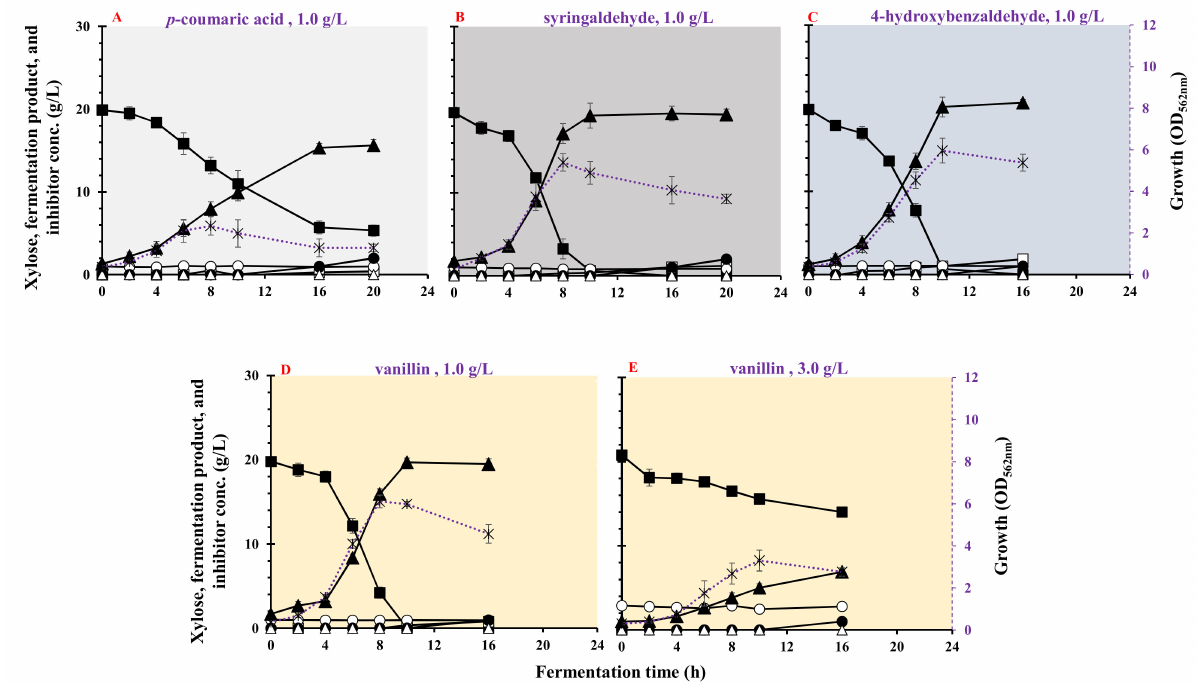
Figure 3. Effect of 1.0 g/L of p -coumaric acid ( A ), syringaldehyde ( B ), 4-hydroxybenzaldehyde ( C ), and 1.0–3.0 g/L vanillin ( D , E ) on the growth and lactic acid production by Bacillus coagulans Azu-10. Symbols: (cid:4) , xylose (g/L); (cid:3) , acetic acid (g/L); , inhibitor (g/L); • , formic acid (g/L); ∆ , ethanol (g/L); (cid:78) , lactic acid (g/L); *, growth (OD 562nm ). The standard deviation (cid:35) is less than the size of symbols if no error bars are seen. Table 4. Effect of phenolic compounds on lactic acid fermentation efficiency by Bacillus coagulans Azu-10. Max. LA Max. LA Residual Residual µ max LA AceticAcid Ethanol LAYield Biomass Productivity Productivity Phenols Inhibitors (g/L) Xylose Inhibitor (g/L) (g/L) (g/L) (g/g) (h − 1 ) (OD 562nm ) (g/(L · h)) (g/(L · h)) (g/L) (%) p